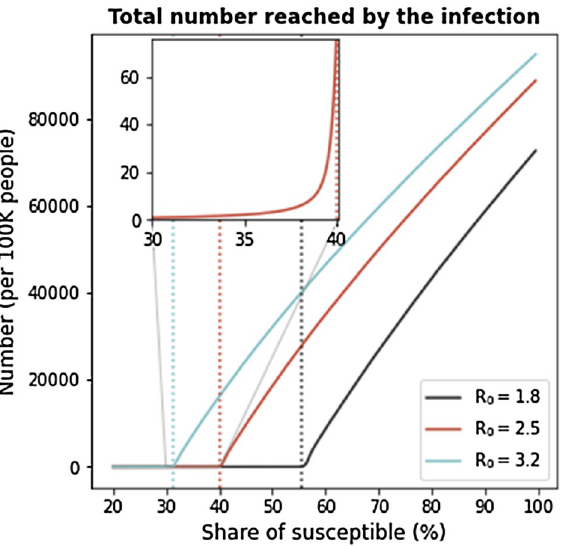
Figure 1. Number of infected individuals as a function of the share of susceptible in the population. When the proportion of susceptible individuals crosses the herd immunity threshold (1/ R 0 ), the number of infections increases drastically. Dotted lines represent herd immunity levels associated with three levels of R 0